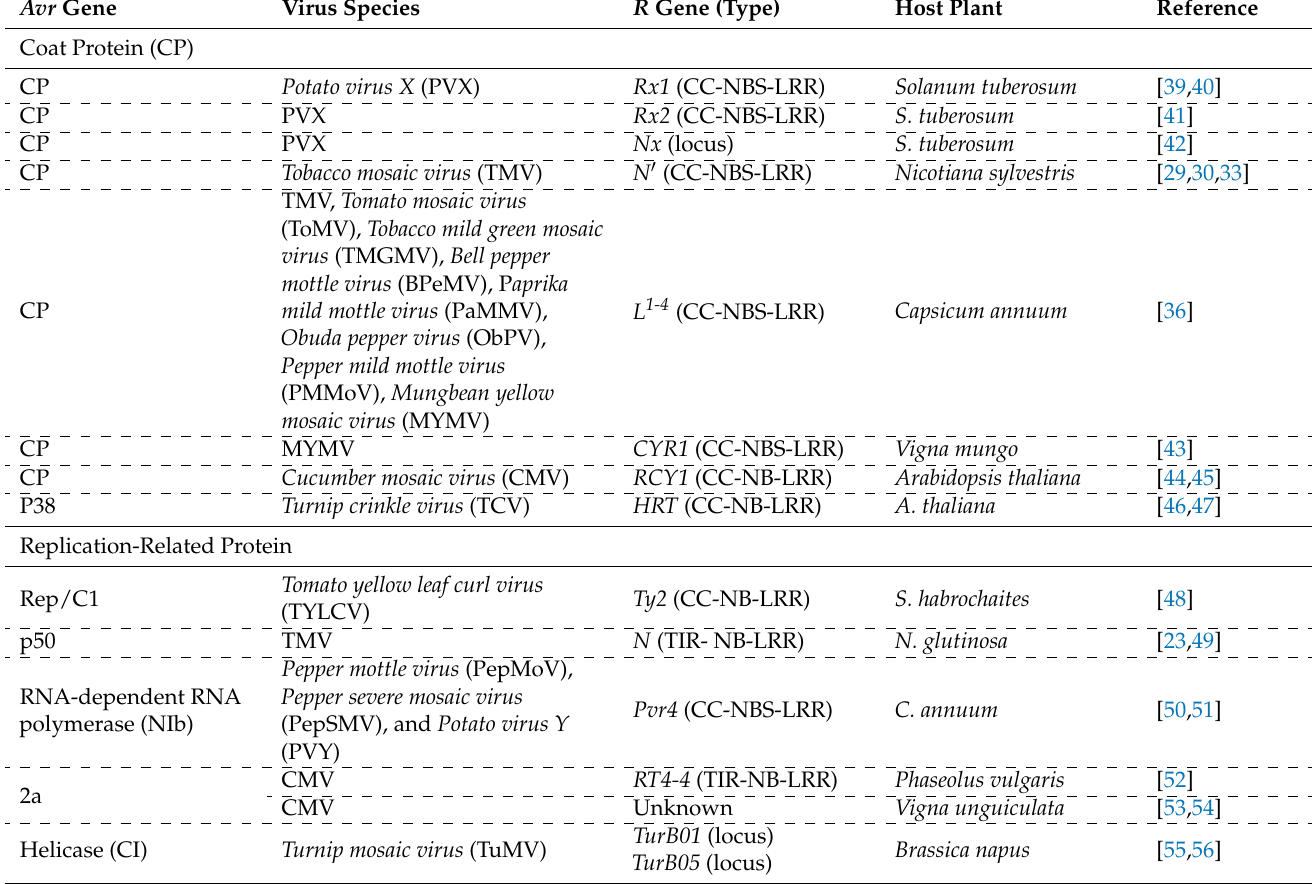
Table 1. Plant virus avirulence (Avr) factor and cognate NB-LRR resistance